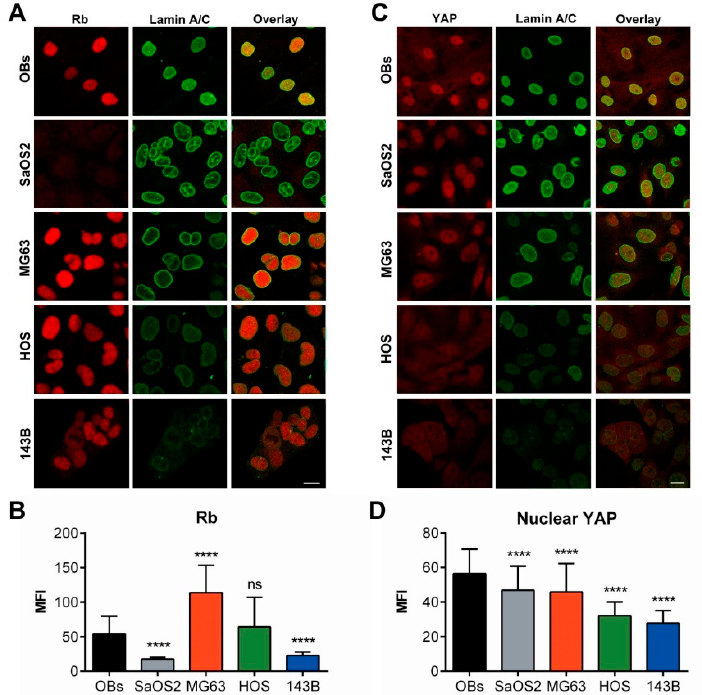
Figure 11. Altered expression of pRb and YAP proteins correlates with lamin A / C expression. ( A ) Confocal imaging of Rb ( red ) and lamin A / C (green) in osteoblasts (OBs) and osteosarcoma cell lines. Rb immunolabeling was reduced in HOS and particularly in 143B cells respect to MG63 cells, whereas SaOS2 cells resulted negative. ( B ) Mean Fluorescence Intensity (MFI) of Rb in OBs and osteosarcoma cell lines. ( C ) YAP immunoreaction was observed in the nuclei of OBs, SaSO2 and MG63 cells whereas it was significantly reduced in higher aggressive cells (HOS and 143B). ( D ) Mean Fluorescence Intensity (MFI) of nuclear YAP in OBs and osteosarcoma cell lines. Bars: 20 µ m. **** p < 0.001; ns: not significant.